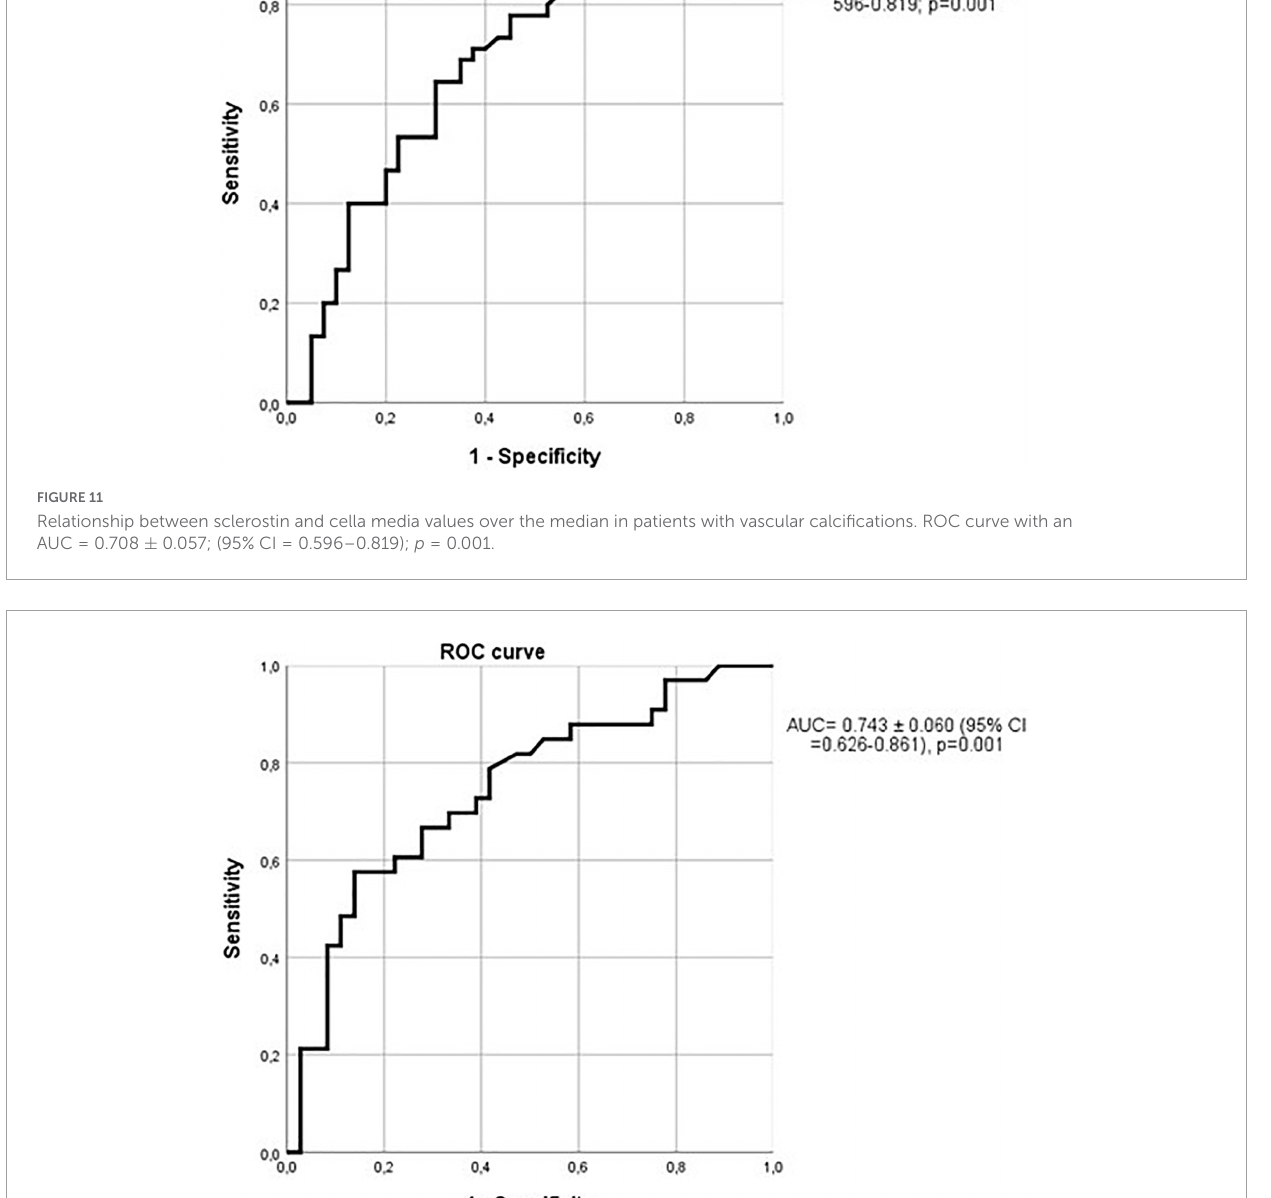
striking result. Of similar importance is the finding observed in non-hypertensive patients, in whom the relation of sclerostin with vascular calcification is even stronger. This may suggest that, at least in alcoholics, sclerostin may be a factor related to vascular damage, independent on hypertension and/or kidney failure (a suggestion also derived from the reported results of the logistic regression